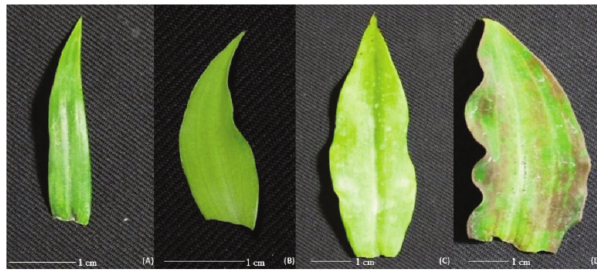
Fig. 5 ­ Leaves of the parents and hybrids. (A) HRA, (B) WXO1, (C) WXO2, (D)